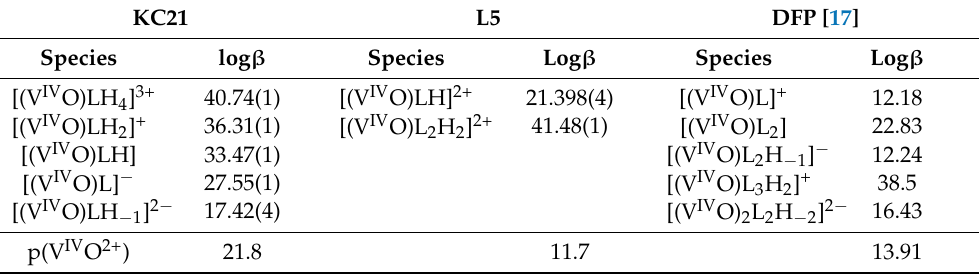
Table 2. Complex formation constants and pM values of V IV O 2+ with KC21, L5 and DFP ligands evaluated from combined potentiometric–UV titrations at 25 ◦ C, 0.1 M NaCl ionic strength